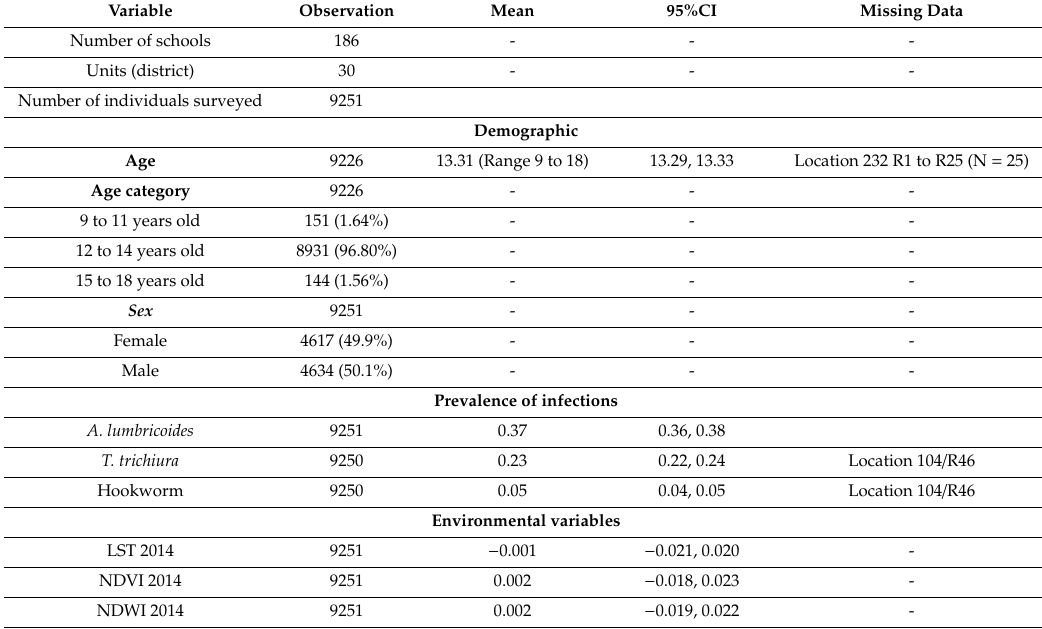
Figure 1. Observed prevalence of A. lumbricoides ( Panel A ), T. trichiura ( Panel B ), and hookworm ( Panel C ) based on Kato-Katz in Rwanda in 2014. This figure was produced in ArcMap 10.4 (ESRI, Redlands, CA) using a shapefile representing Rwanda’s current administrative units (obtained from the data warehouse DIVA GIS). Table 1. Summary statistics of participant demographics and prevalence of soil-transmitted helminth infections across schools in Rwanda in 2014. CI; credible interval; LST: land surface temperature; NDVI: Normalized Difference Vegetation Index; NDWI: Normalized Difference Water Index.